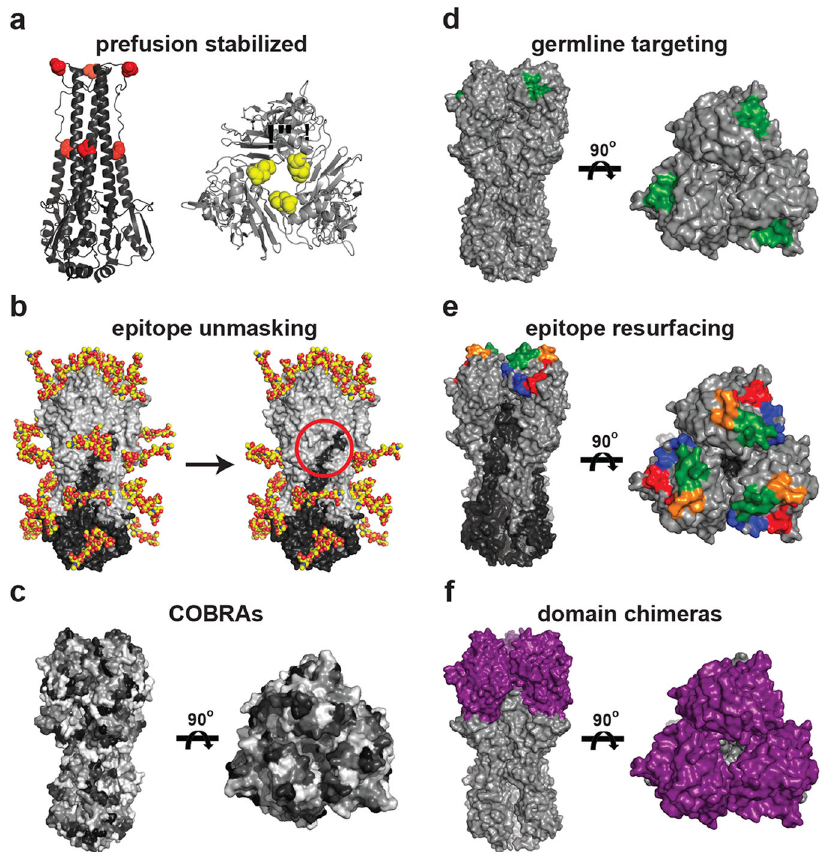
Fig. 2 Design strategies to enhance ‘ on-target ’ epitope responses. a Stem- and head-only HAs indicating locations of engineered prolines (left, red spheres) and inter-HA cysteines (right, yellow spheres) to stabilize the prefusion conformation. b Selective removal of native glycans to expose neoepitopes (red circle). c Computational design of HA antigens based on overall subtype diversity increases cross-reactive responses. To illustrate the COBRA approach, HA is arbitrarily colored in gray shading to show variation in amino acid identity that ultimately contributes to the consensus sequence; for a complete description see Huang et al. 131 . d Optimization of a single epitope for a speci fi c class of B cell precursors increases initial antigen af fi nity. HA receptor binding site (RBS) is shown in green as an example. e Resurfacing of a complex conformational-speci fi c epitope allows for heterologous boosting of subdominant responses within memory. S1 – S4 segments of the grafted RBS shown in red, orange, green, and blue, respectively. f Chimeric HAs where head domain (purple) of an antigenically distinct non- circulating HA is transplanted onto a conserved circulating stem domain (gray) to preferentially target stem-directed responses. All images created in PyMol using PDB